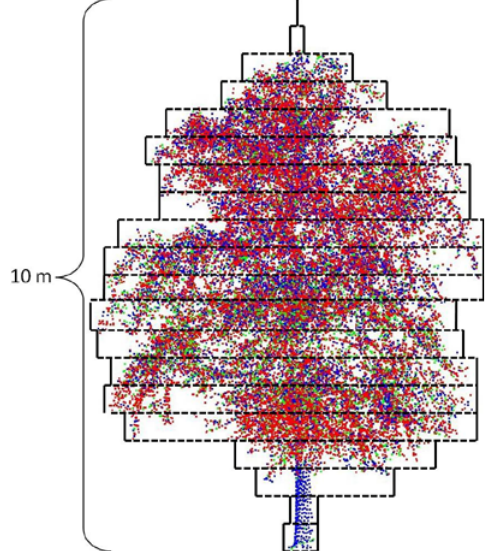
Figure 3. The point sets are divided into at maximum 20 blocks with an overall height of 10 m. For every block the average width, volume and the dimensionality factors are